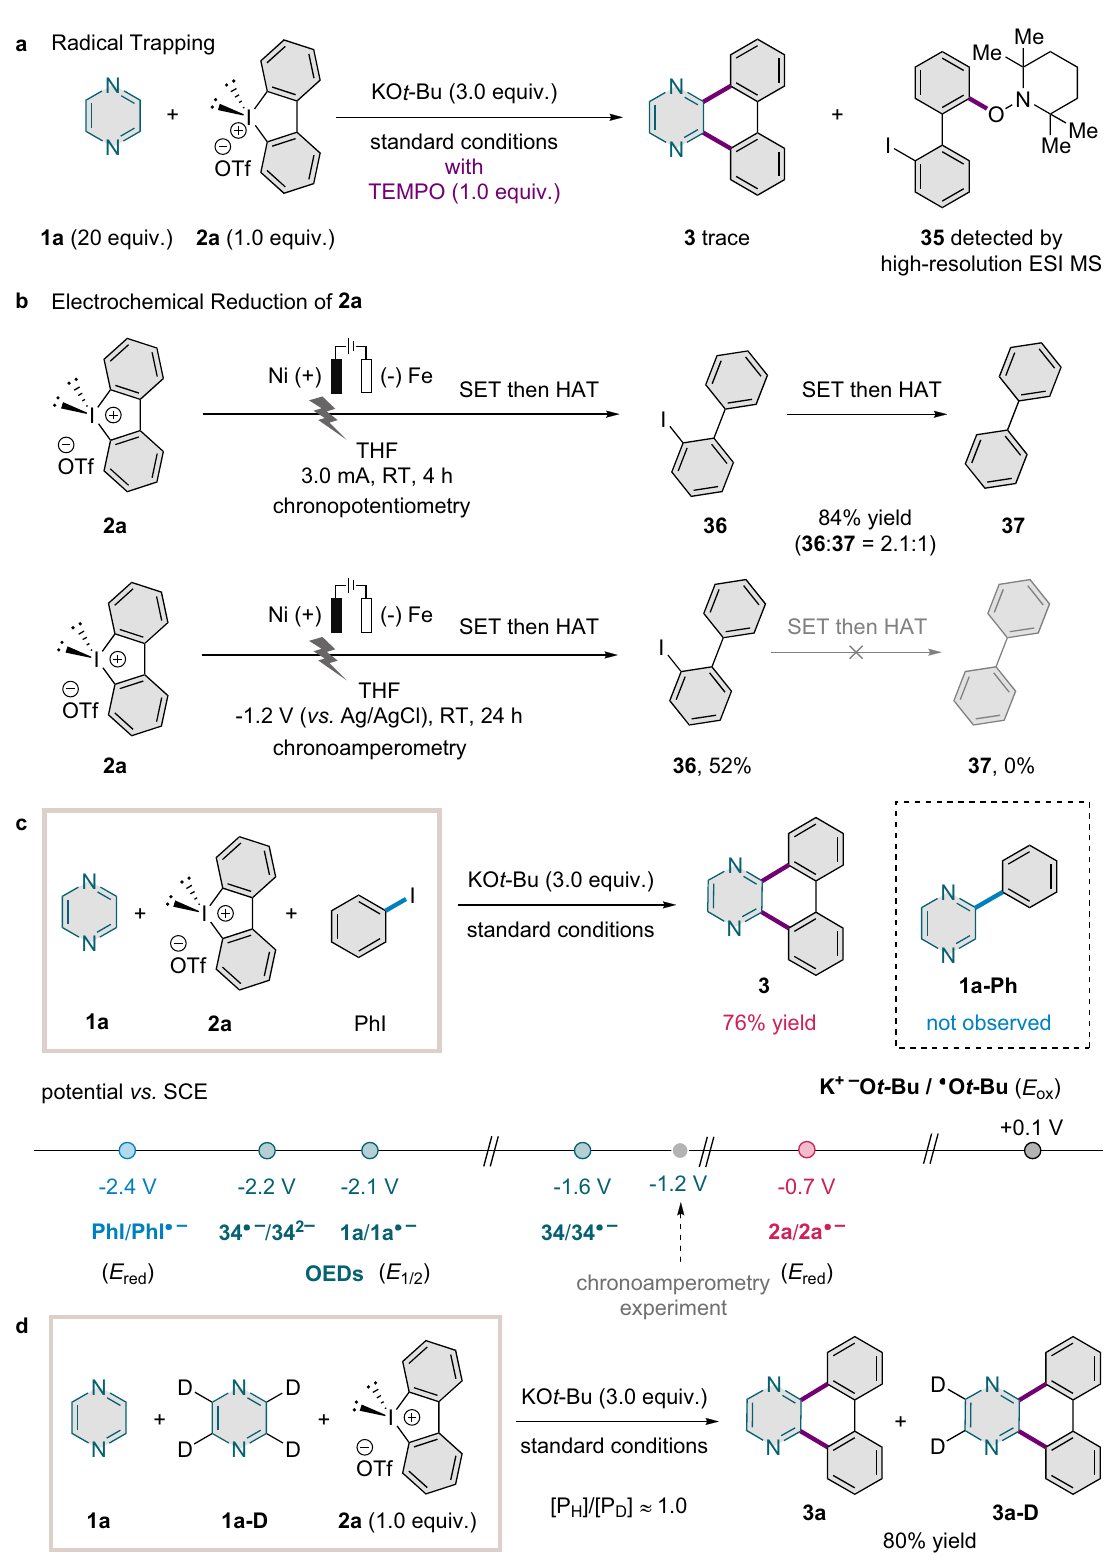
Fig. 5 Mechanistic studies. a Radical trapping. b Electrochemical reduction of 2a . c Competition experiments and CV measurements. Potentials were converted to the SCE scale using ferrocene as an external standard, where necessary. d KIE